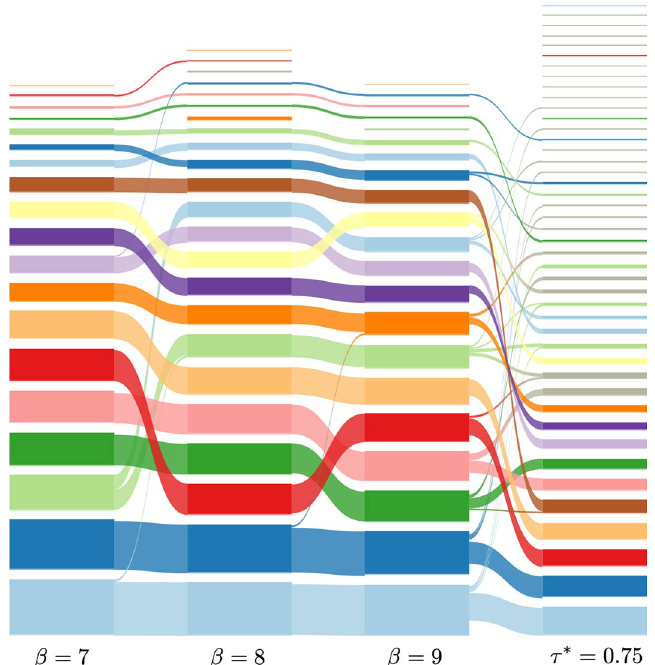
Fig. 7 WGCNA underfits modules. The allluvial diagram shows Infomap modules and reveals that the networks derived using WGCNA with different β values give less modular structure than the network corresponding to threshold τ ∗ = 0.75 . This shows that WGCNA underfits the modular structure in the